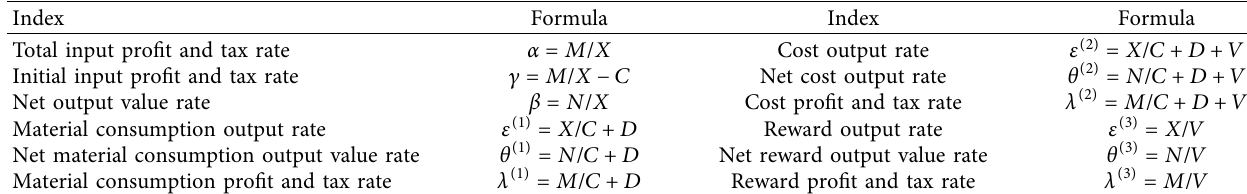
Table 2: Economic Benefit Indexes to be Calculated.